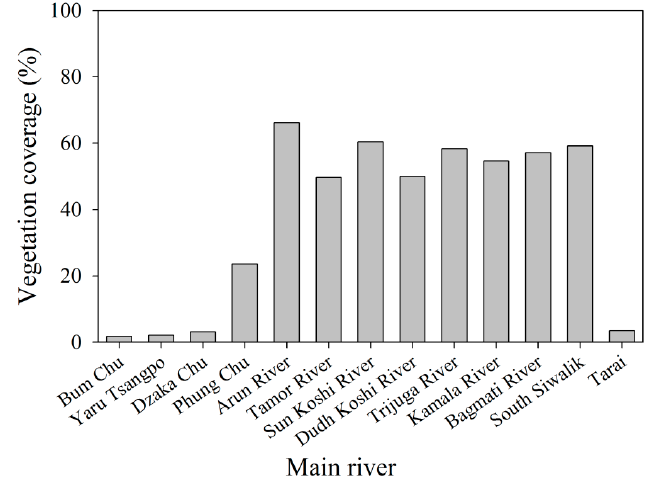
Figure 8. Vegetation coverage from different rivers in the Koshi River Basin (KRB).